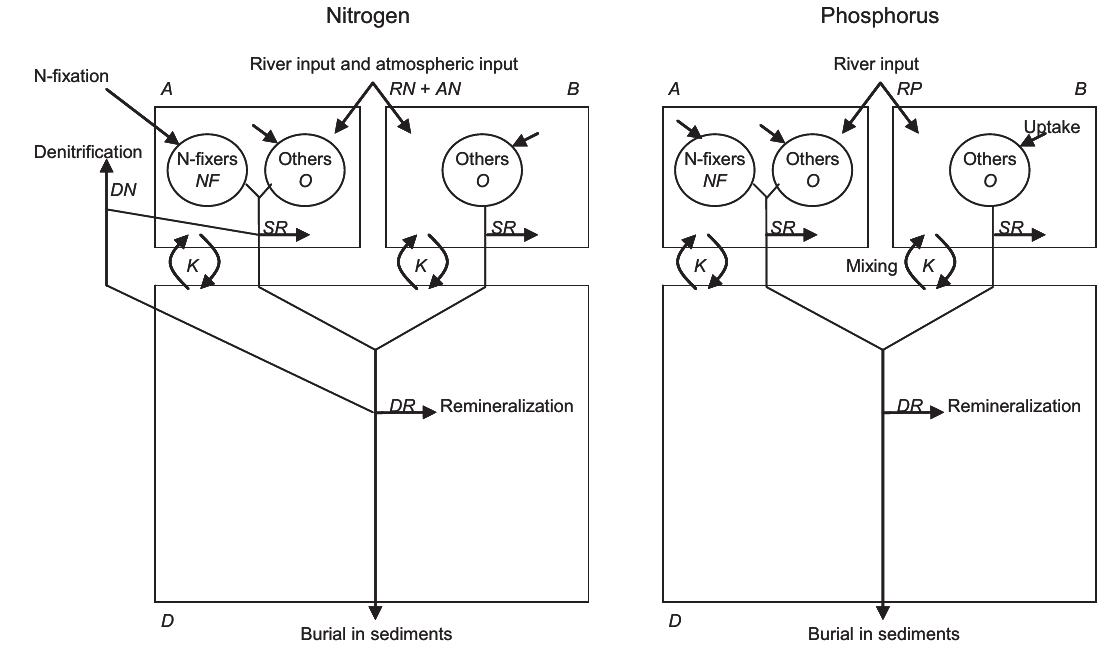
Fig. 2. Schematics of the nitrogen and phosphorus cycles in the extended TT model, where arrows indicate fluxes. The model has two surface ocean boxes ( A , B ) and a deep ocean box ( D ). Within box A there are populations of nitrogen fixers and other phytoplankton. Within box B there are only other phytoplankton. Where possible, fluxes are labelled and model variables and constants are indicated in italics. Mixing ( K ) occurs between each surface box and the deep box but not between the two surface boxes. N enters the surface boxes from rivers ( RN ) and atmospheric deposition ( AN ). P enters from rivers ( RP ). Biological uptake of nutrient is indicated by an arrow from within a surface box to a population. N is also fixed from outside the system directly into the N 2 -fixers. Mortality is represented by lines leaving the populations, forming sinking fluxes of nutrients. For both nutrients, a fraction ( SR ) of the sinking flux is remineralised in the surface layer and a fraction ( SD ) in the deep box. For N, a fraction ( DN ) is also lost by denitrification. The remaining sinking fluxes of nutrients leave the system as burial in